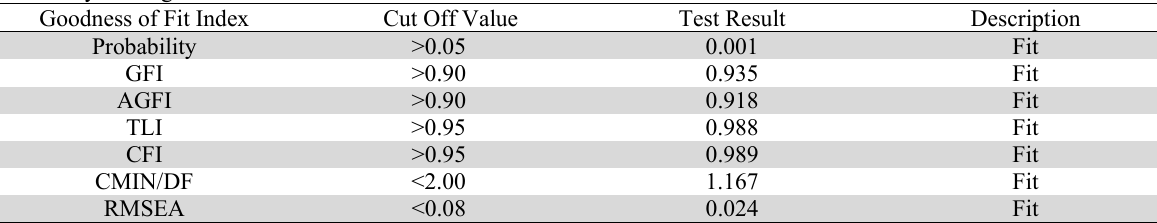
Feasibility Testing